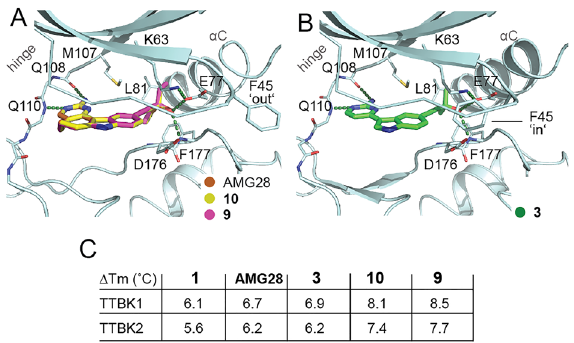
Figure 2. X-ray crystallographic structures of human TTBK1 in complex with several analogs and corresponding thermal shift data for TTBK1/2. ( A ) AMG28 (PDB code: 7ZHN) is shown in brown, 10 (PDB code: 7ZHQ) in yellow, and 9 (PDB code: 7ZHP) in pink stick representation, respectively. Image created using Schrödinger PyMOL 2.5. ( B ) 3 (PDB code: 7ZHO) is shown in pink. The hinge region and αC helix are labeled in each panel and hydrogen bonds are included as black dashed lines. Image created using Schrödinger PyMOL 2.5. ( C ) Table of thermal shift (ΔTm) data for TTBK